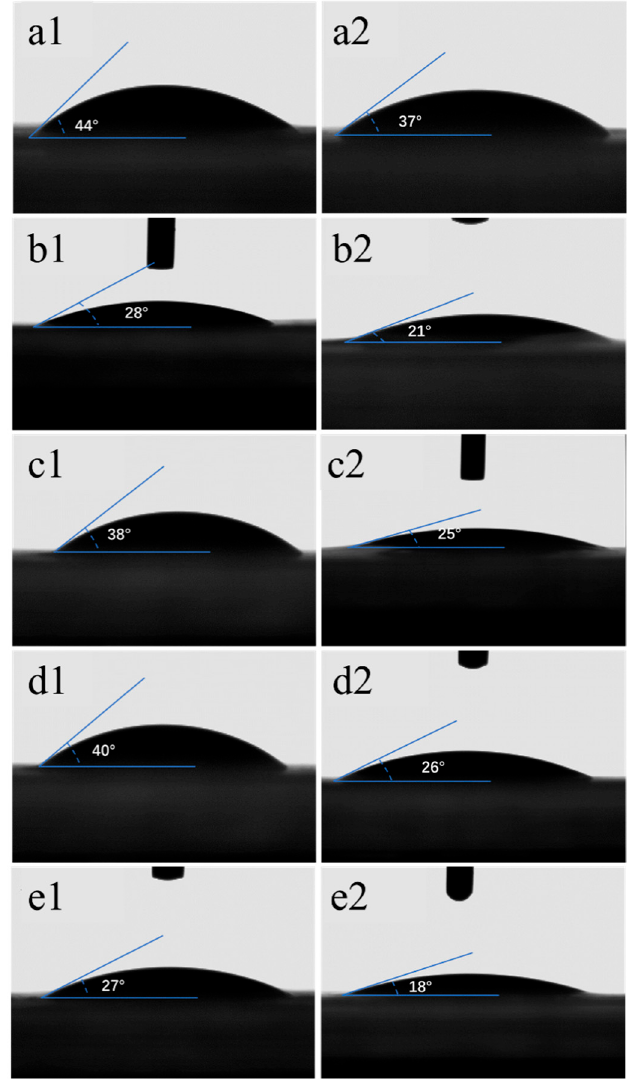
Figure 5. The contact angles of water on the surface of the cellulose membranes before and after the homogenization: ( a1 , a2 ) bamboo pulp; ( b1 , b2 ) hardwood pulp; ( c1 , c2 ) softwood pulp; ( d1 , d2 ) cotton pulp; ( e1 , e2 ) hemp pulp.